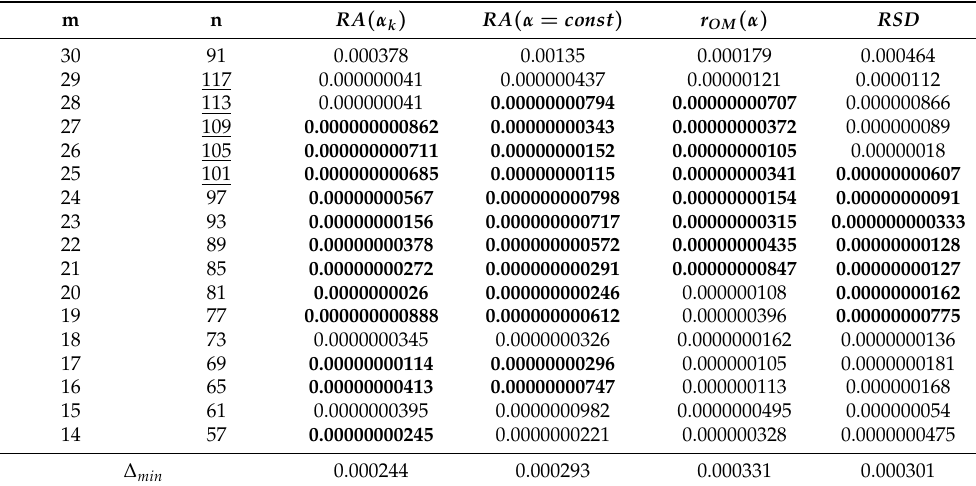
Table 12. Results of function f 8 ( x ) approximation by a sigmoidal ANN with a regularizer R γ ( w )